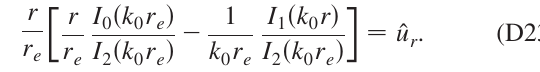
=k " and k are evaluated for Q ¼ 10 (cid:1) 4 , and all other quantities are (cid:5) 0 (cid:5) 0 b 0